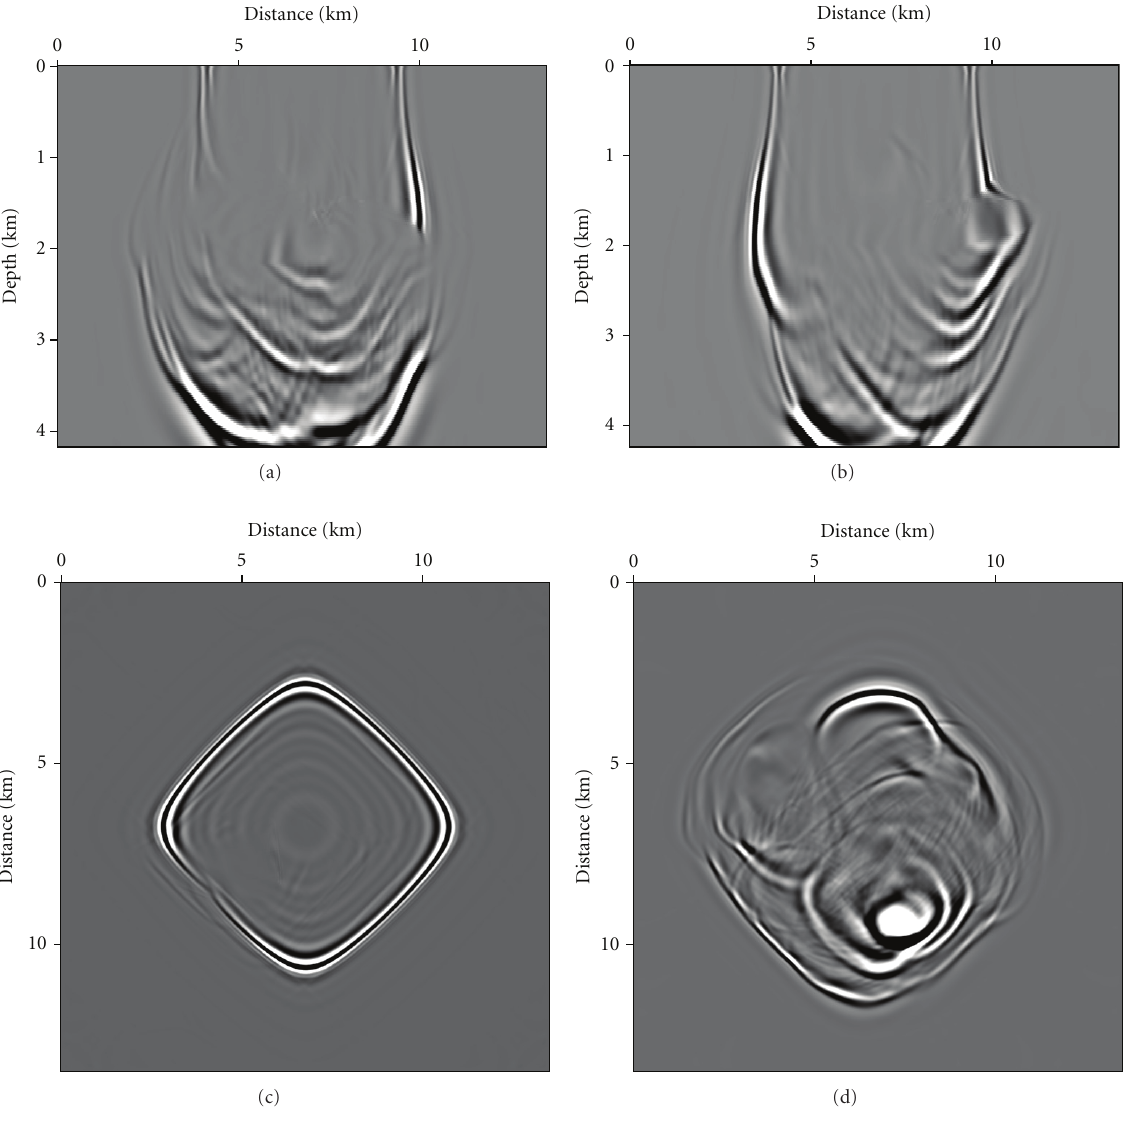
Figure 3: Impulse response obtained by FD migration using the complex Pad´e approximation without Li correction (cross-sections as